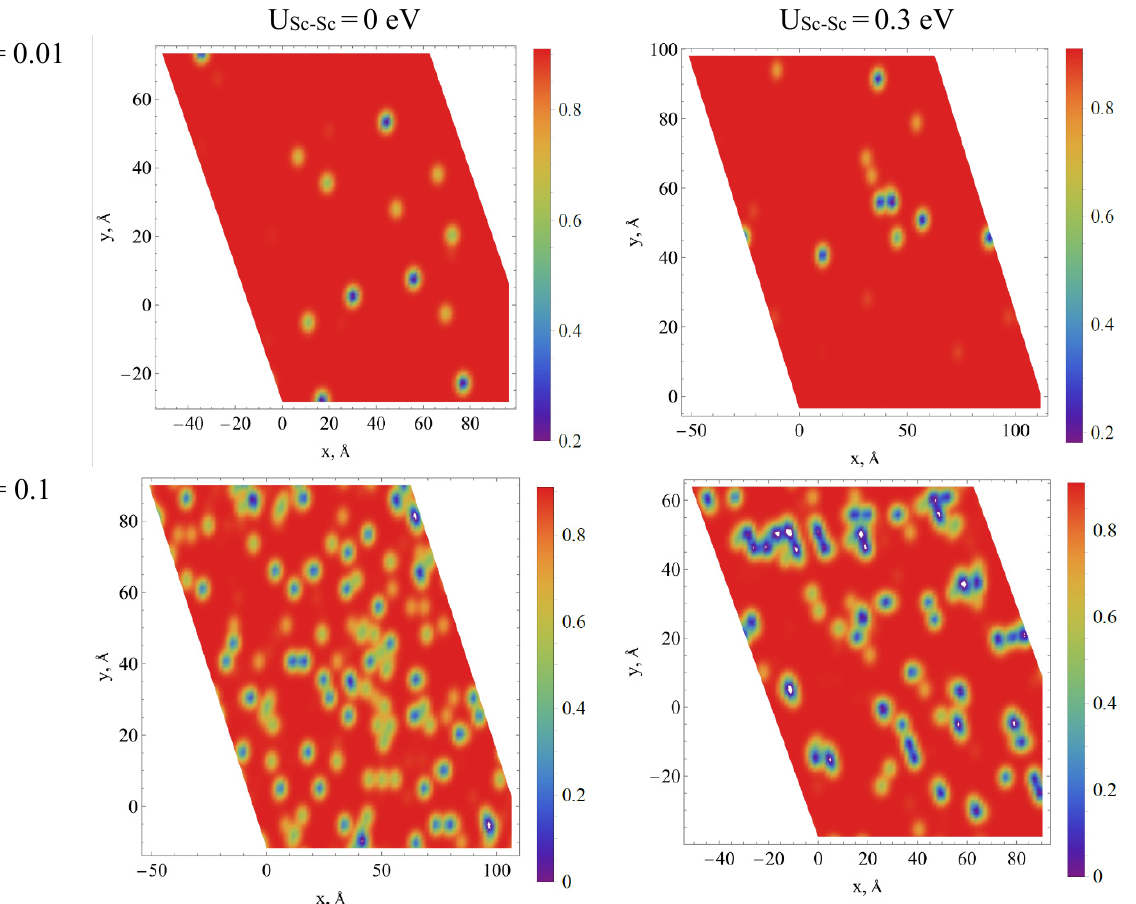
Figure 9. Examples of 2D cross-section of potential landscape without ( left column ) and with ( right column ) account for the Sc-Sc correlation for x = 0.01 and x = 0.1.